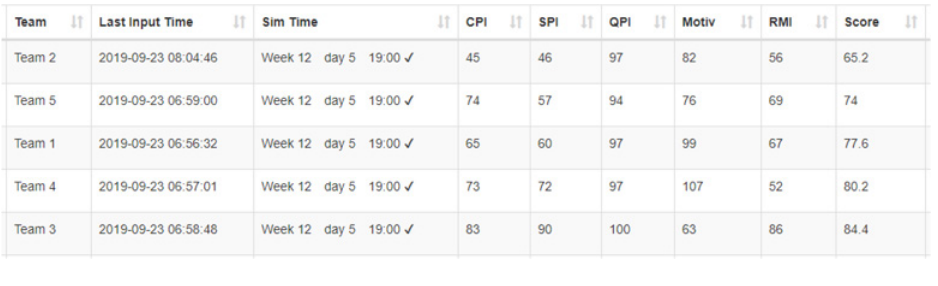
SimulTrain ® team performances (n=5)